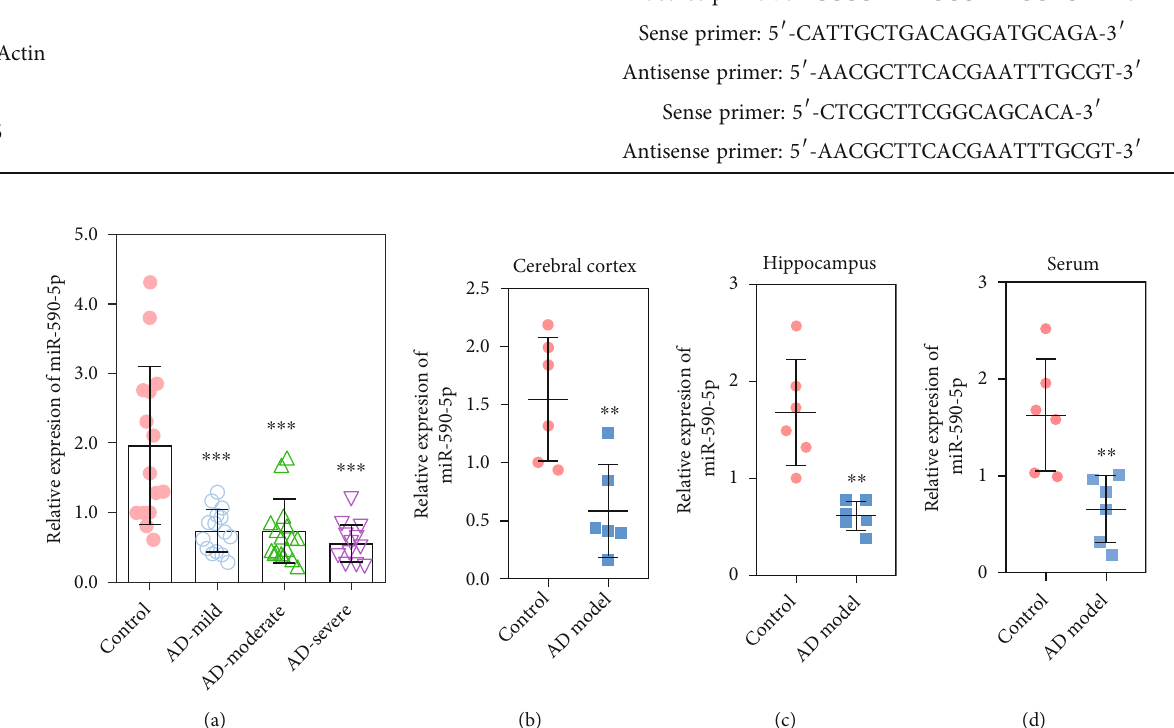
Figure 1: The level of miR-590-5p was lower in AD patients and mice model. (a) The miR-590-5p level in serum of AD patients at mild, moderate, and severe stage as well as healthy volunteers by qPCR ( n = 15 ). (b – c) The miR-590-5p level in the cerebral cortex tissue, hippocampal tissue, and serum from wild-type mice (control) and APP/PS1 transgenic mice (AD model) by qPCR ( n = 6 ). Each experiment was repeated three times. ∗∗ P < 0 : 01 and ∗∗∗ P < 0 : 001 vs. control